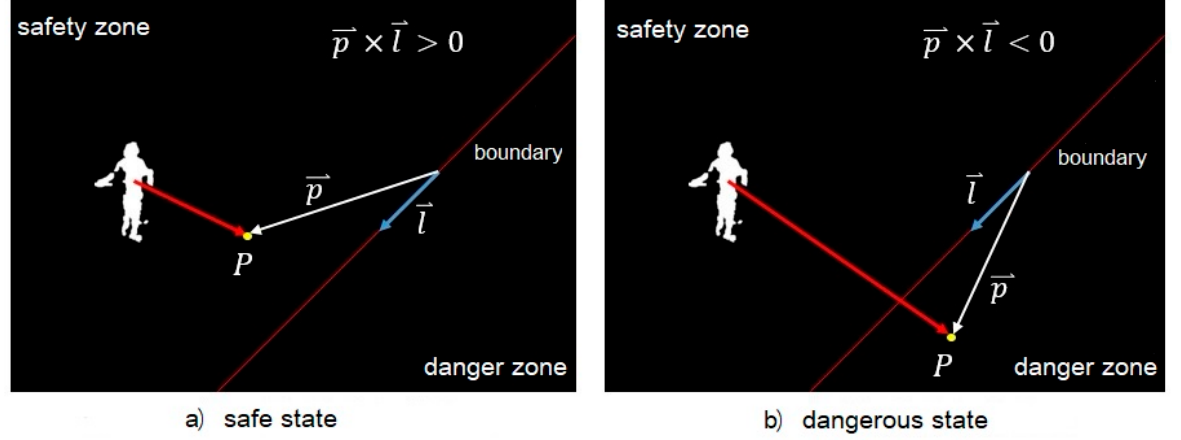
Figure 12. Method of danger determination.